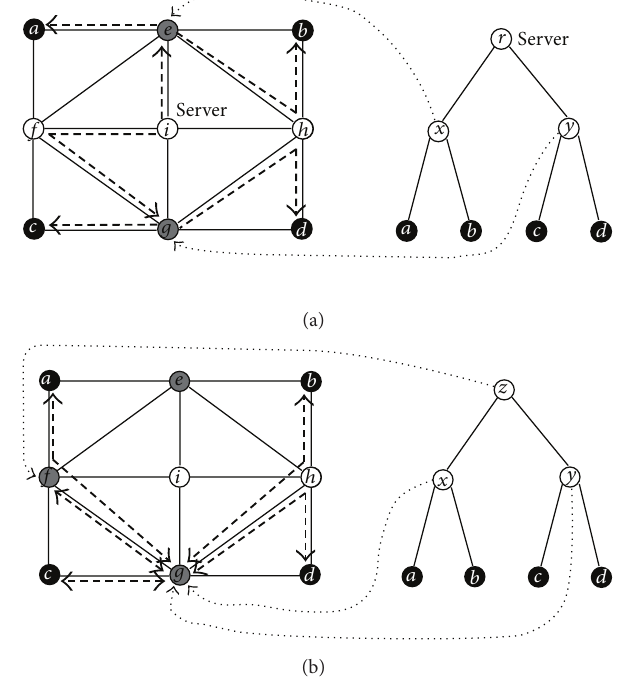
Figure 2: For ease of view, we neglect the numbers on edges. The example network for MCMP and the binary tree topology are both the same as those shown in Figure 1 and the integer on every edge represents its quantity of cost. The minimum cost multicast tree for the centralized MCMP is drawn with the bold dashed edges on the top subfigure and the one for the decentralized MCMP is drawn on the bottom